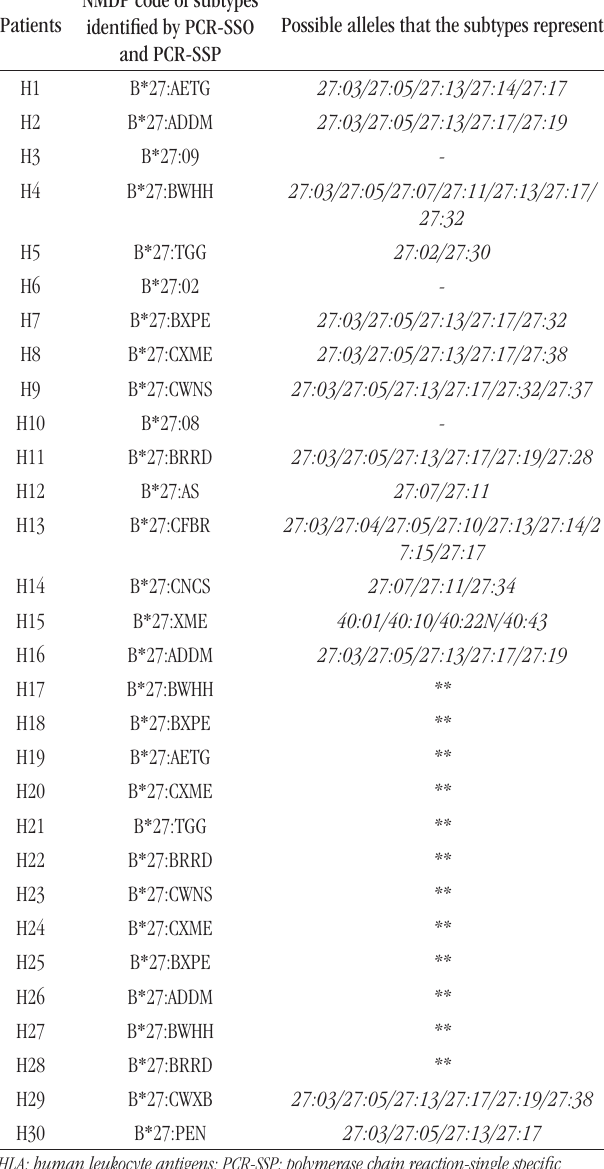
taBLE 1 − Positive results for HLA-B*27 by PCR-SSO and PCR-SSP methods NMDP code of subtypes Possible alleles that the subtypes Patients identified by PCR-SSO and PCR-SSP